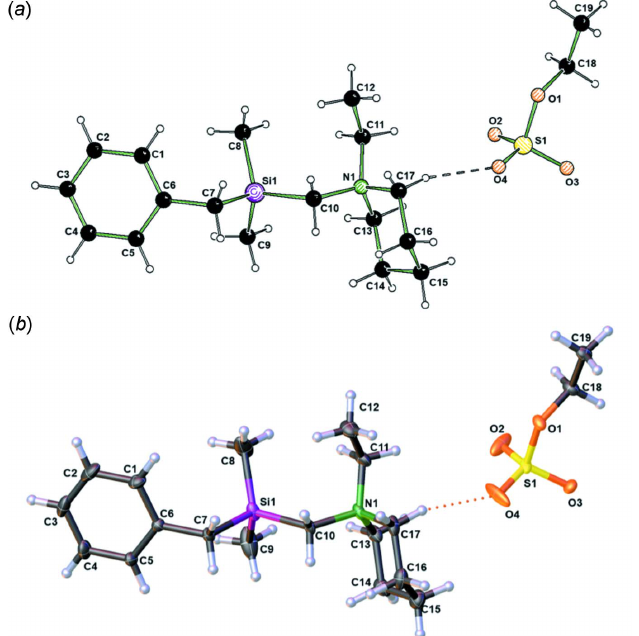
Figure 2 Visualization of the calculated structure of compound 1 with Molekel 4.3 (Flu¨kiger et al. , 2000) performed at the M062X/6–31+G( d ) (Ditchfield et al. , 1970; Zhao & Truhlar, 2008) level.